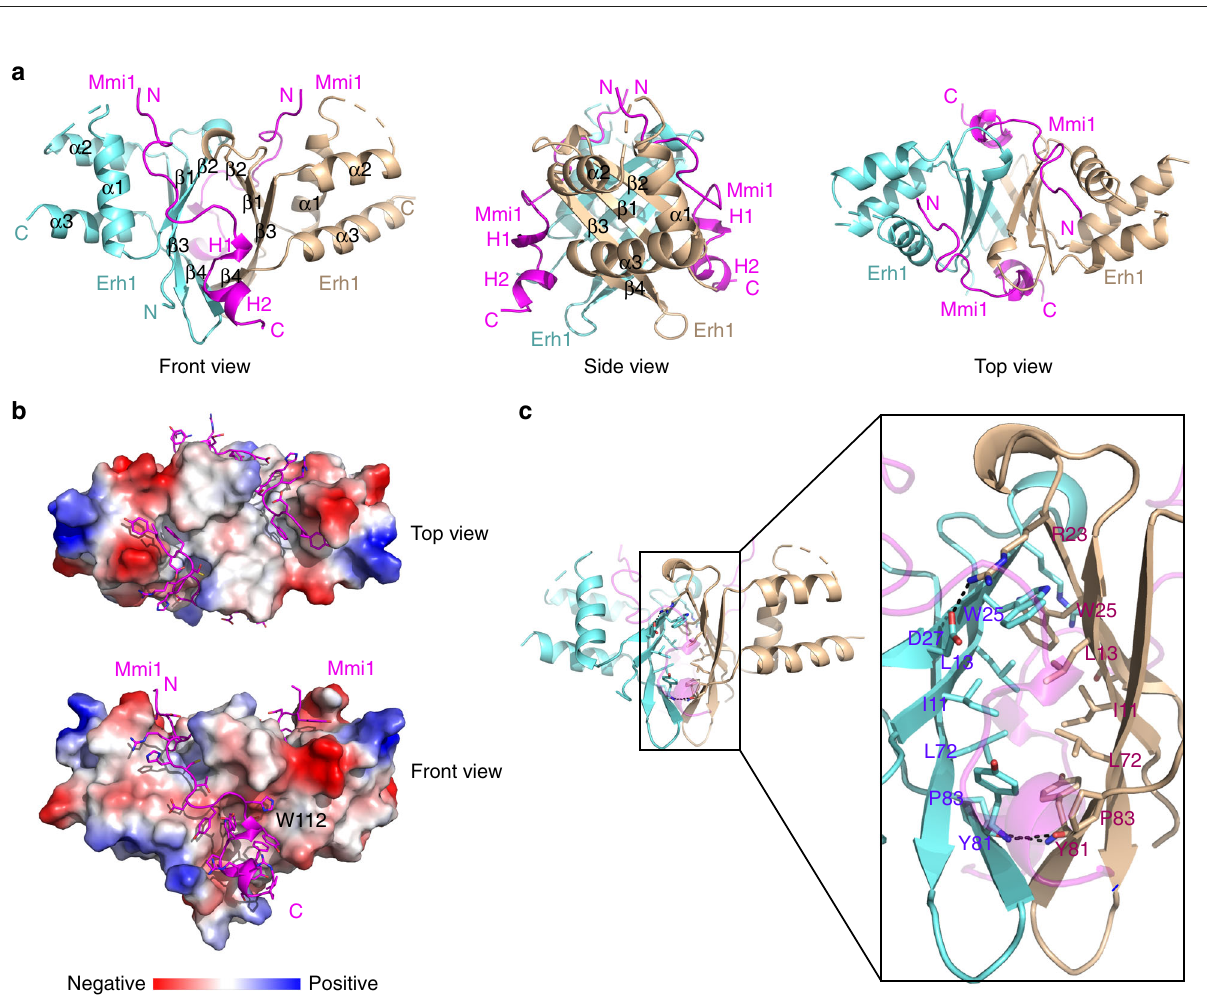
Fig. 1 Mmi1 interacts with Erh1 in a 2:2 stoichiometry. a Shown is a schematic representation of the domain architecture of Mmi1. The disorder score from DISOPRED3 Server 62 and the conservation score are shown below. The conservation score is generated by a Protein Residue Conservation Prediction Server 63 from the sequence alignment of Mmi1 orthologues from S. pombe , S. cryophilus , S. octosporus , and S. japonicus . b – d Interactions of GST tagged Mmi1 peptides (GST-Mmi1) with Erh1 visualized by Coomassie blue staining. The indicated GST-Mmi1 fusion proteins or GST alone were incubated with Erh1. The complexes were collected with glutathione-agarose resin and bound proteins were eluted and then subjected to SDS-PAGE. GST or GST-Mmi1 fusion proteins without Erh1 are shown as a negative control. Source data are provided as a Source Data fi le. e The raw ITC titration data of Erh1 with SUMO tagged Mmi1 95 – 122 and its fi tting curve are shown. K D dissociation constant, DP differential power, N binding stoichiometry, Δ H binding enthalpy. f ITC fi tting curves of Erh1 using SUMO tagged Mmi1 95 – 122 (magenta), Mmi1 106 – 122 (blue) and Mmi1 95 – 111 (green) are shown. g Size-exclusion analysis of Erh1 (magenta) and Erh1-Mmi1 95 – 122 (blue). Marker sizes are 62.9 KDa (Albumin), 46.7 KDa (Ovalbumin), 20.3 KDa (Chymotrypsinogen), 14.6 KDa (Ribonuclease A). Also shown are theoretical monomer sizes (kDa) of Erh1 protein and Mmi1 95 – 122